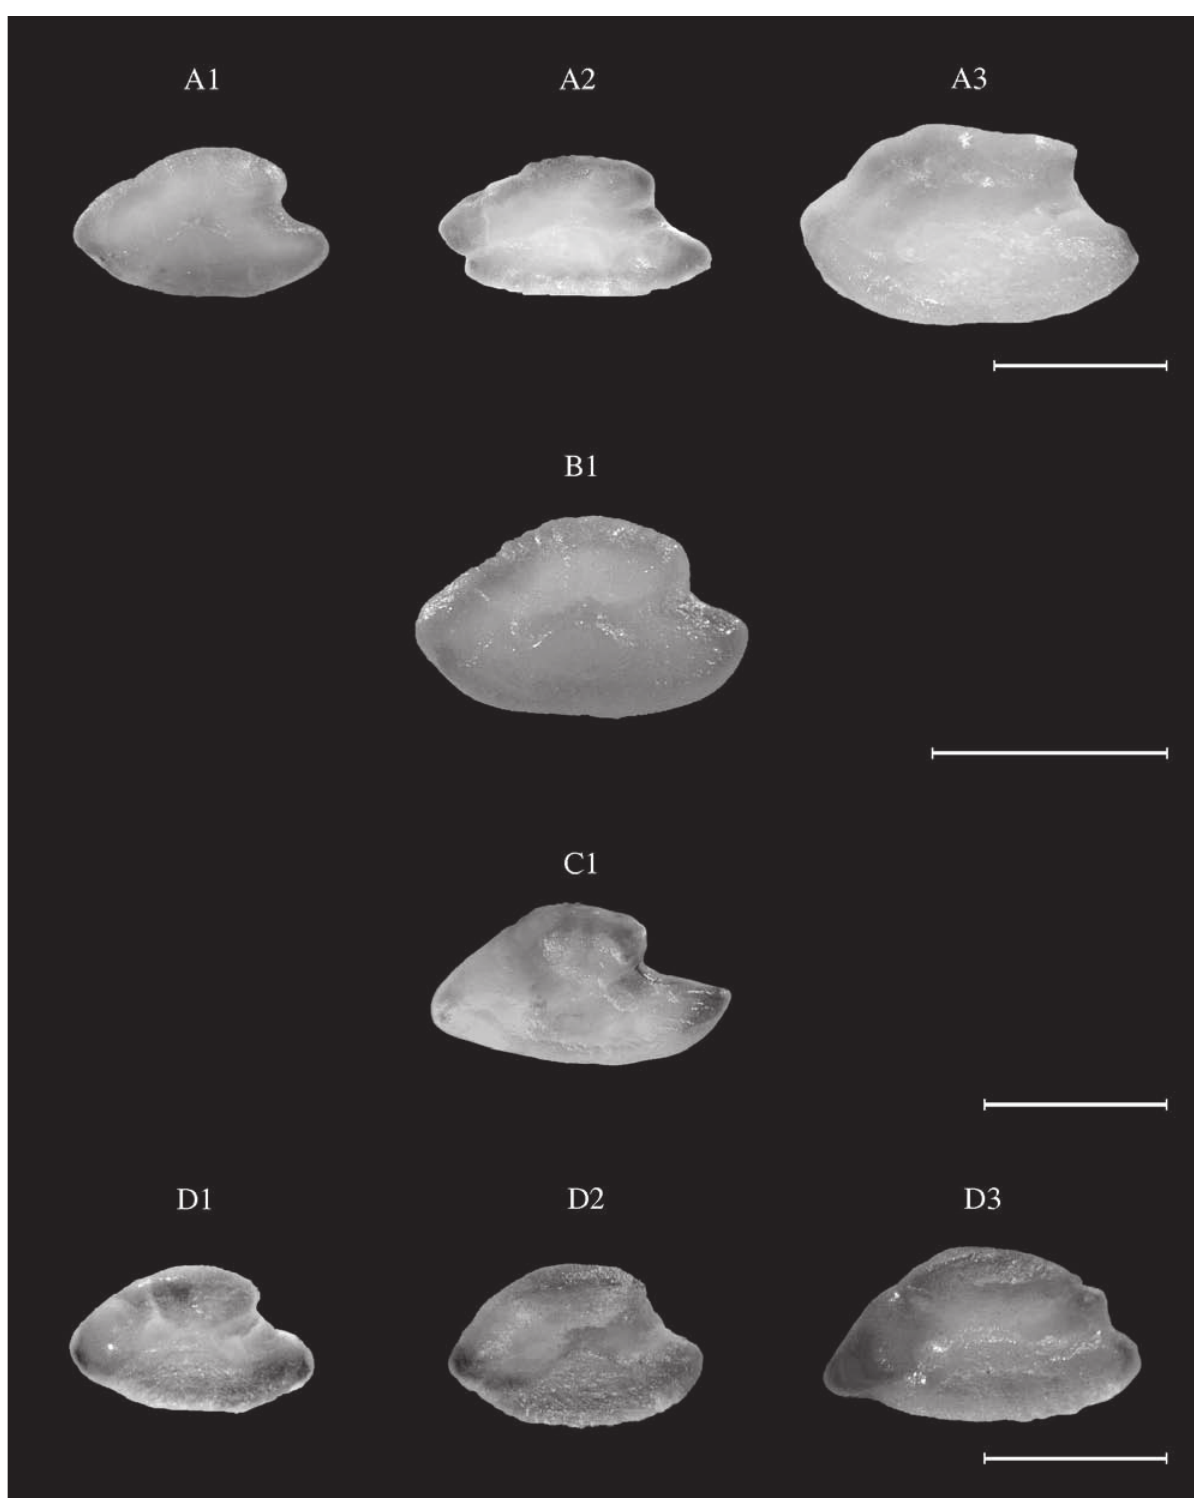
Fig. 77. – Parablennius pilicornis. TL: A1, 6.3 cm (NEA); A2, 7.9 cm (WM); A3, 8.9 cm (WM). Parablennius rouxi (NEA). TL: B1, 6.4 cm. Parablennius tentacularis (WM). TL: C1, 7.0 cm. Scartella cristata (WM). TL: D1, 8.2 cm; D2, 8.5 cm; D3, 9.7 cm. Scale bar = 1